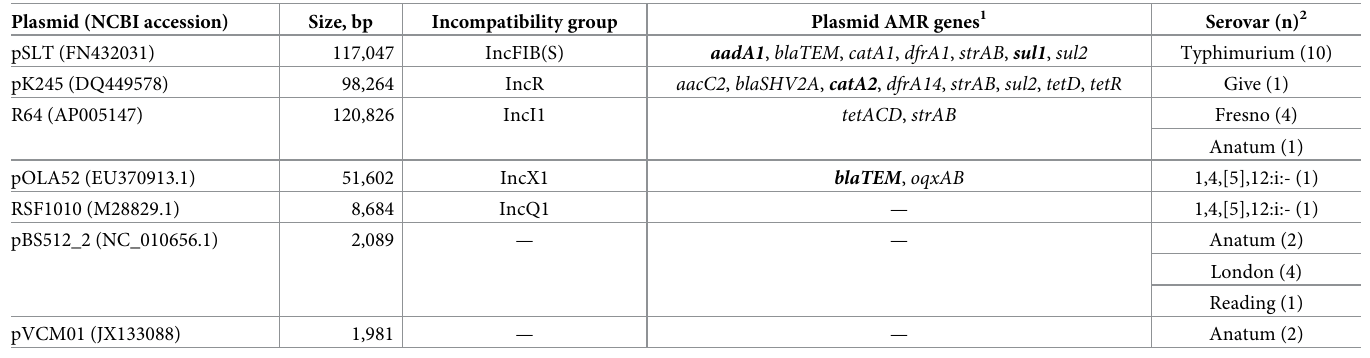
Table 2. General features of the plasmids predicted per Salmonella